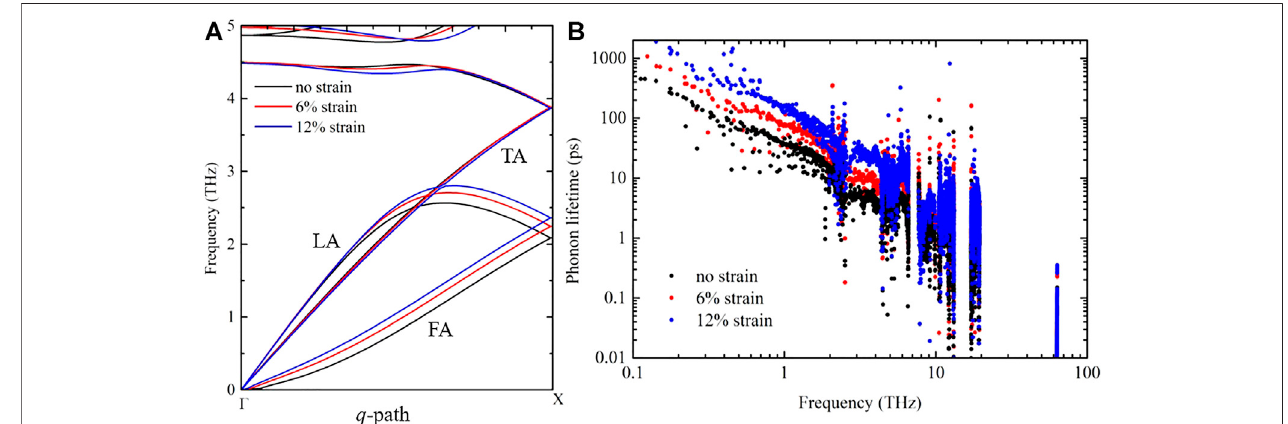
FIGURE3|(A) Phonondispersioncurvesofacousticphononbranchesofpenta-SiHalongthe Γ − X directionattypicaltensilestrains.Forbrevity,onlytheacoustic phononbranchesareshown.Thethree acousticphononbranchesarelabeled withFA( fl exuralacoustic),TA(transvers acoustic),and LA(longitudinalacoustic). (B) The corresponding frequency-dependent phonon lifetime of penta-SiH.